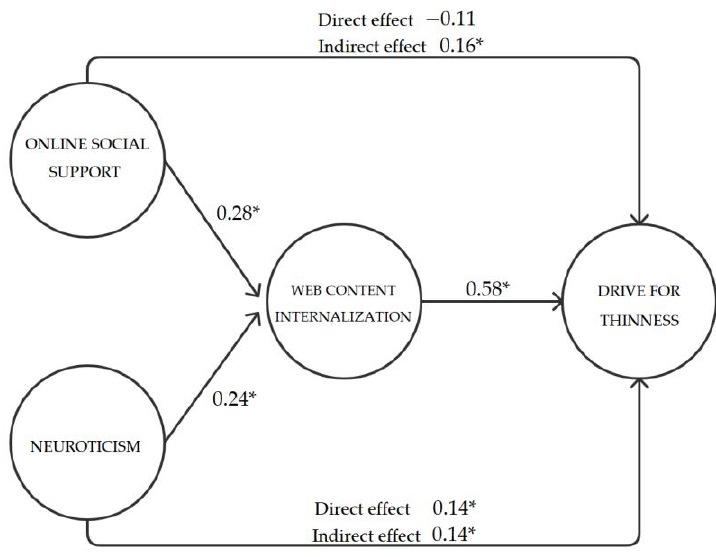
Figure 1. Path diagram with standardized regression coefficients (β). Note: * designates p < 0.05 .